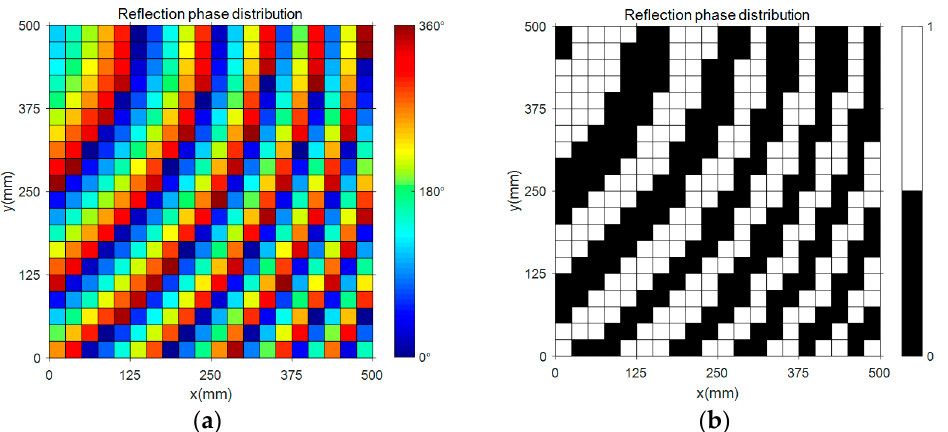
Figure 4. Reflection phase distribution on the RRM when θ r = 60 ◦ ( a ) Accurate phase distribution; ( b ) Digital phase distribution.